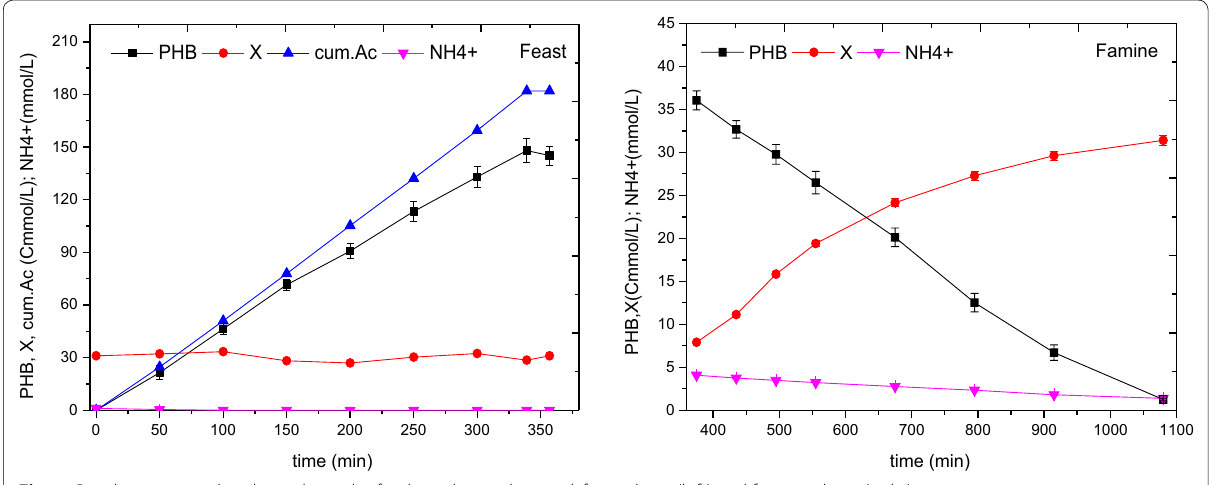
Fig. 5 Results in a typical cycle applying the feed-on-demand control, feast phase (left) and famine phase (right)